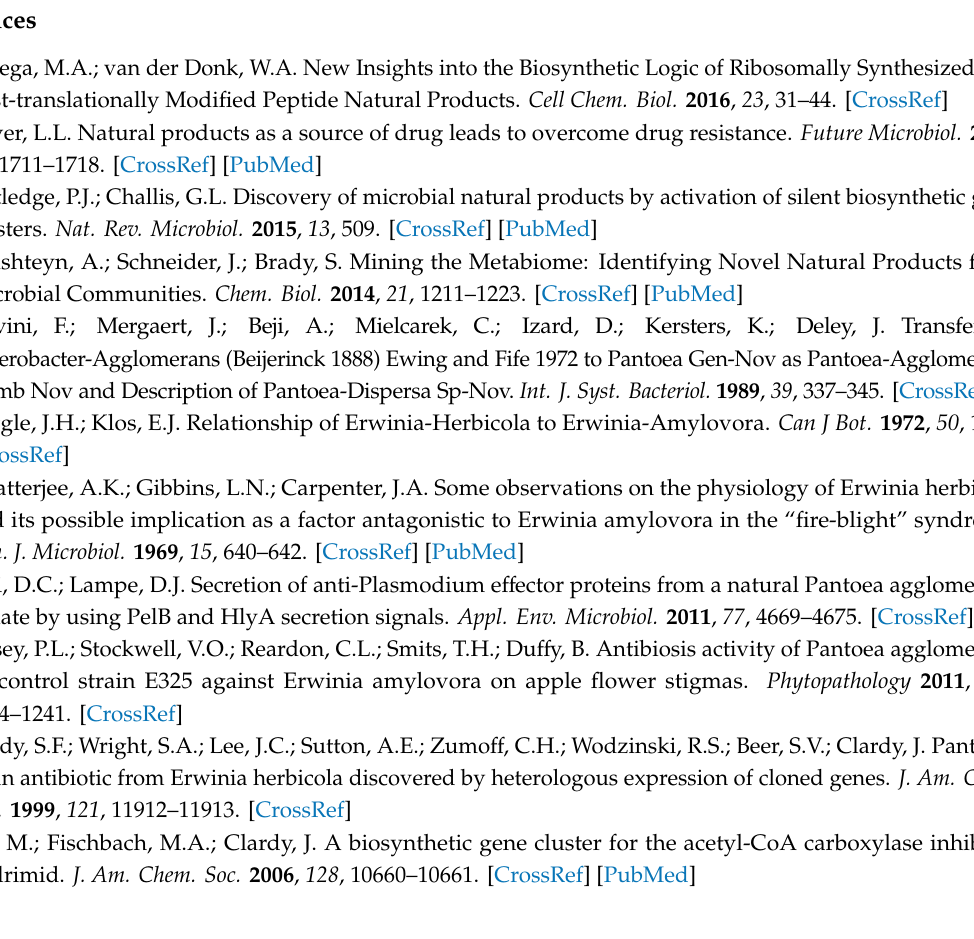
Supplementary Materials: The following are available online, Figure S1: (a) Further purification of pantocin wh-1 was performed by HPLC with a C18 reverse column, and the fraction at 13.234 min had anti-mycobacterial activity; (b) a linear gradient used in this study, Figure S2: (a) The upper figure shows that the molecular weight of the pantocin wh-1 sample was 1927 Da using MALDI-TOF / MS analysis; (b) the middle figure shows that the molecular weight of pantocin wh-1 treated with proteinase K was changed to 1456 Da; (c) the lower figure shows the molecular weight of pantocin wh-1 purified by HPLC, Table S1: E ff ects of enzymes, heat, and pH on pantocin wh-1 activity, Table S2: Antimicrobial spectrum of pantocin wh-1 produced by P. dispersa